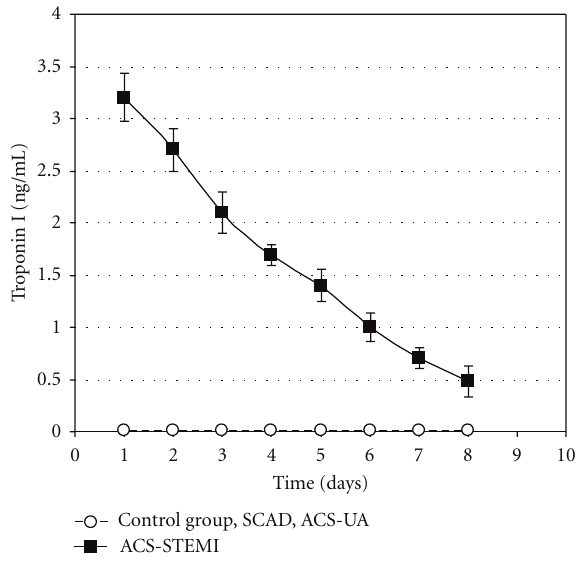
Figure 2: Troponin I blood concentration (ngmL − 1 ) in control group ( n = 32), stable coronary artery disease patients (SCAD, n = 28), acute coronary syndrome, nonocclusive type, patients (ACS-UA, n = 26), and acute coronary syndrome, occlusive type, patients (ACS-STEMI, n = 37) during the eight-day period of testing. Troponin I blood concentrations in control, SCAD, and ACS-UA groups were in normal physiological range during the whole investigated period (less than 0.01 ngmL − 1 ). The data are presented by means ± SEM.